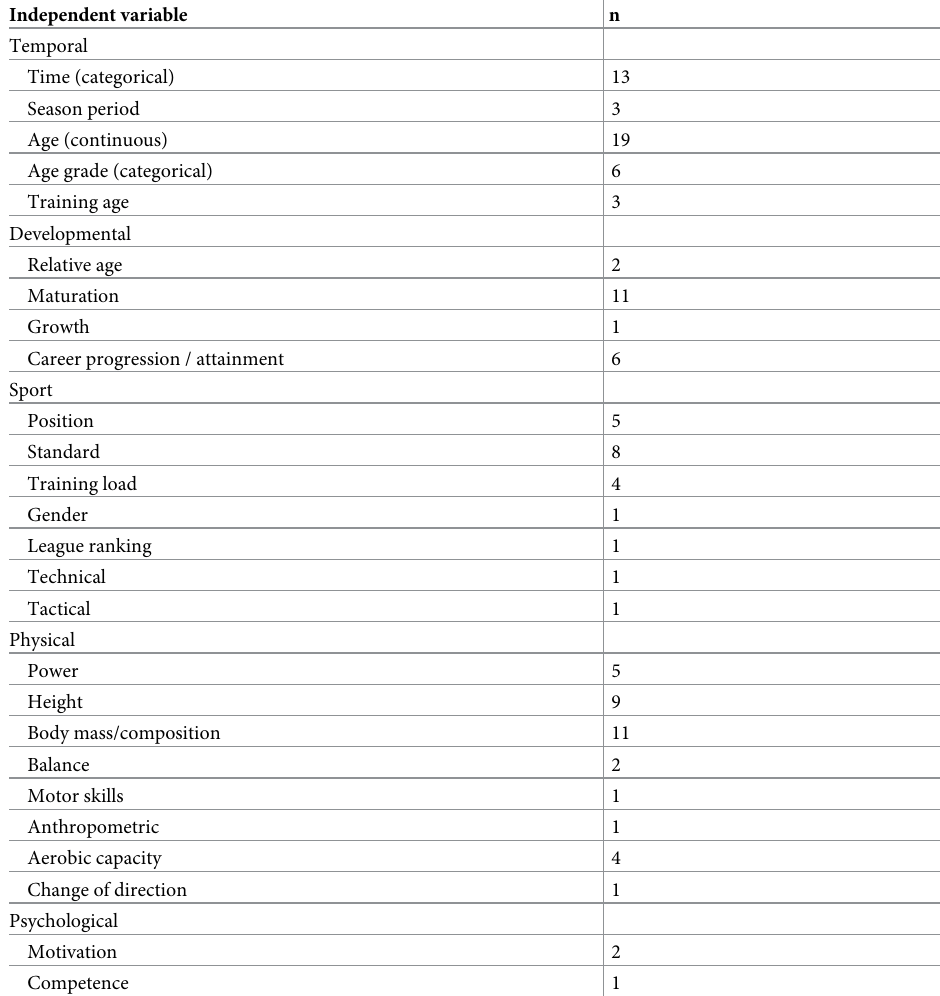
Table 4. The independent variables used to evaluate the development of physical